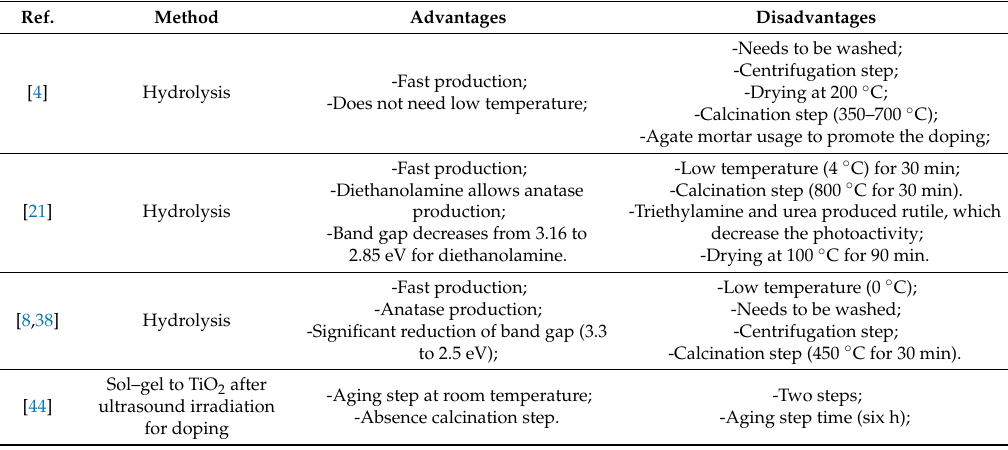
Table 1. Advantages and disadvantages of N–TiO 2 preparation